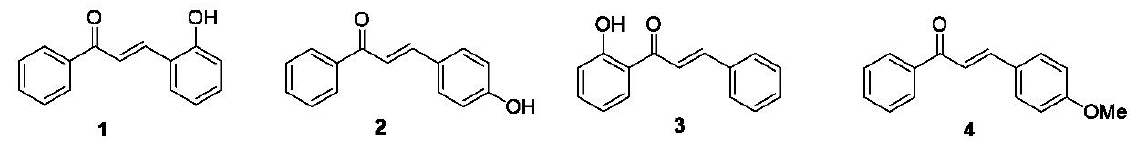
Figure 2. Natural chalcones 1 – 4 .